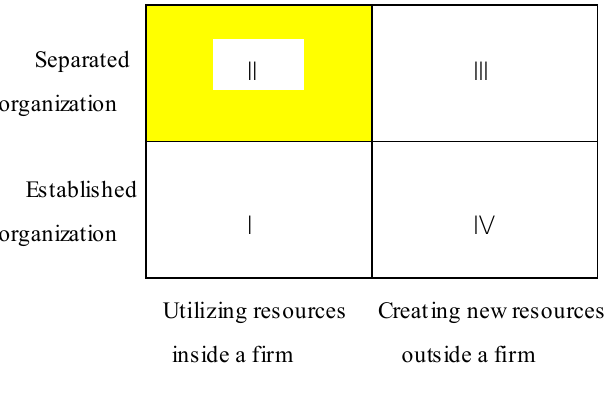
Figure3. New pattern of organization